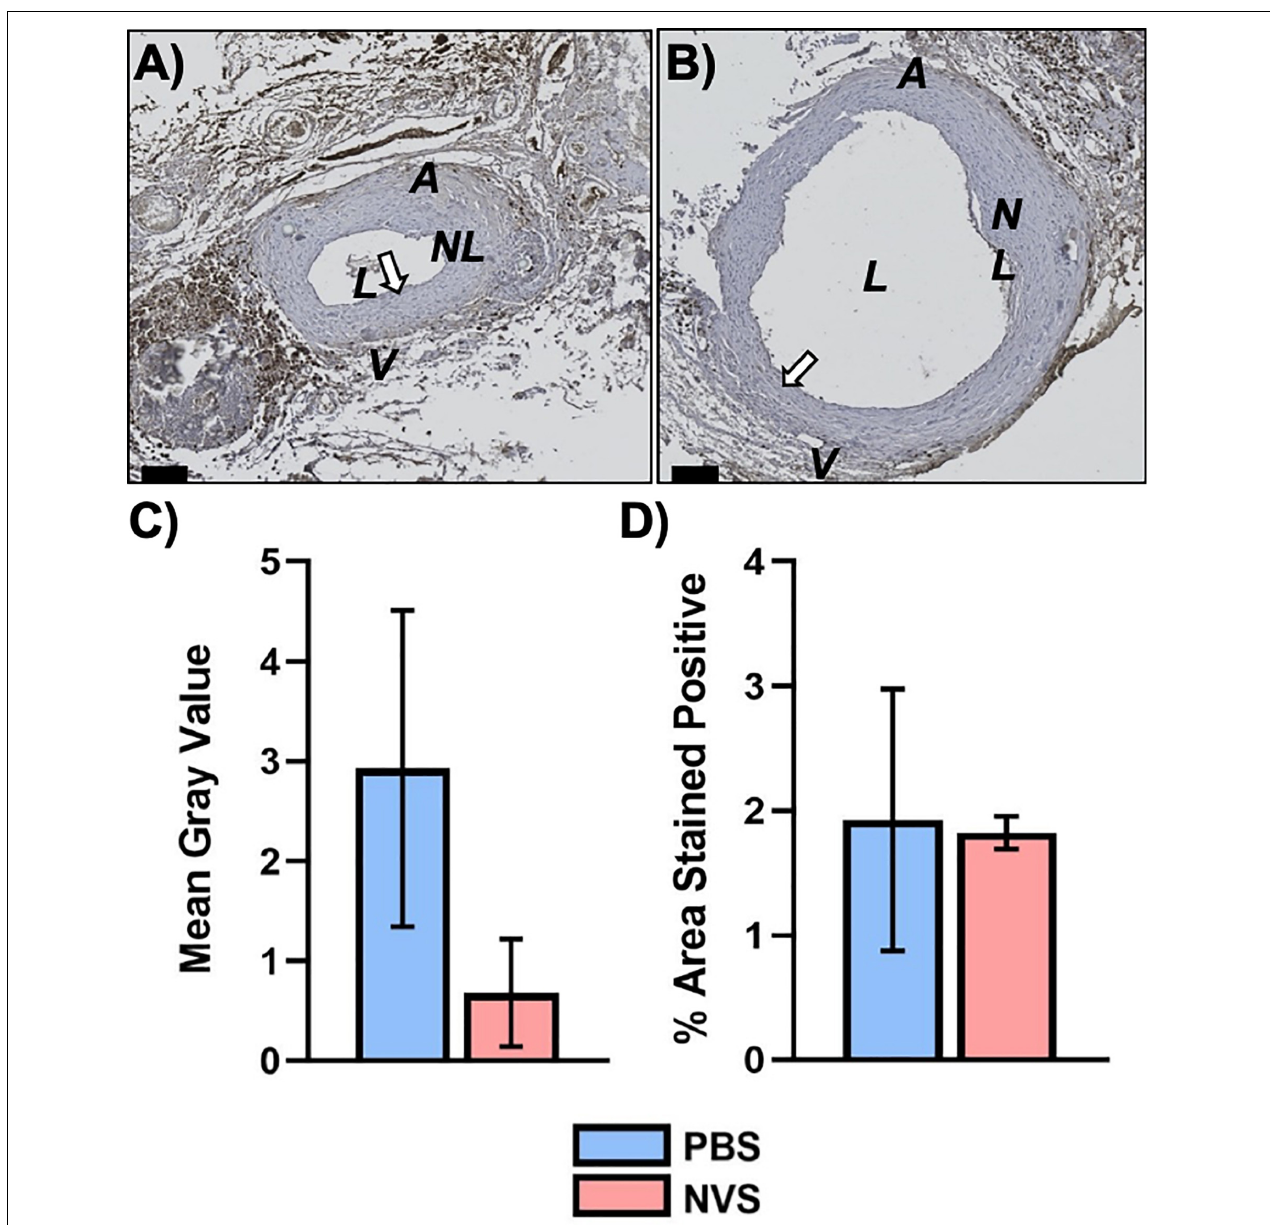
FIGURE 5 | Ki67 analysis. Representative immunohistochemistry images of Ki67 (A,B) staining of the AVF anastomoses at 4 weeks from animals treated with PBS (A) and NVS (B) . (C) Quantification of staining intensity (i.e., mean gray value). (D) Quantification of the percent area stained positive. Analyses were performed for the whole AVF. Results are presented as average ± standard error of mean. N = 3 per group. Scale bar = 100 µ m. A = Arterial limb of AVF. V = Venous limb of AVF. L = Lumen. NL = Neointimal lesion. White arrows indicate example regions of positive